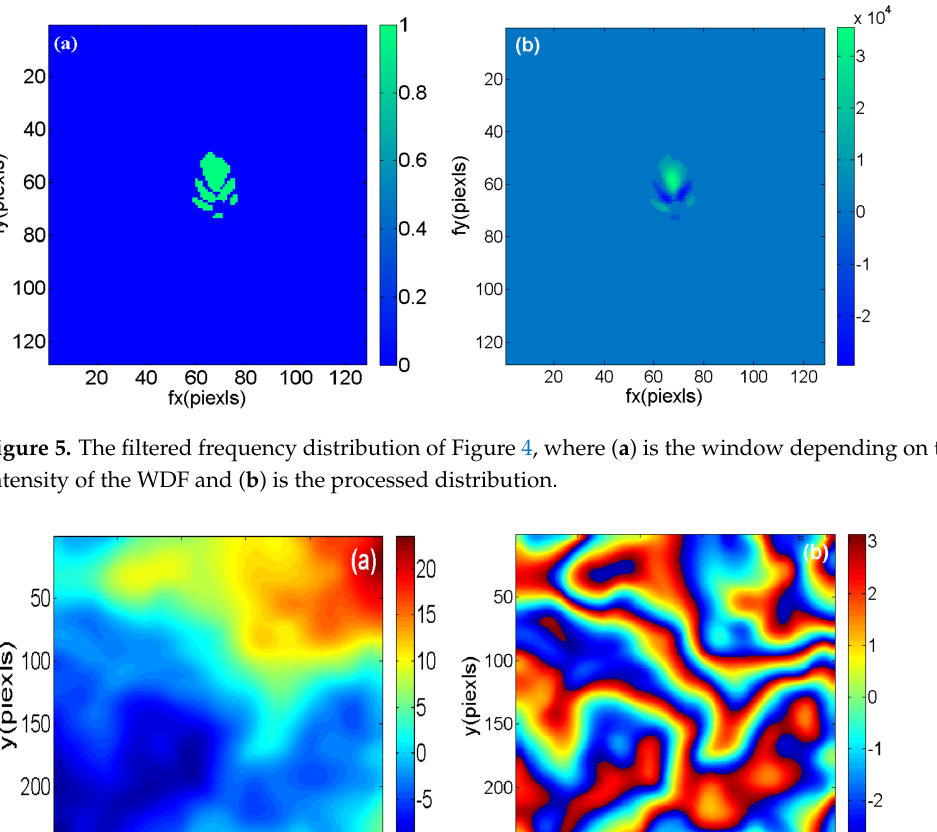
Table 1. Mean-squared error (MSE) of each filtering method in Figure 8.